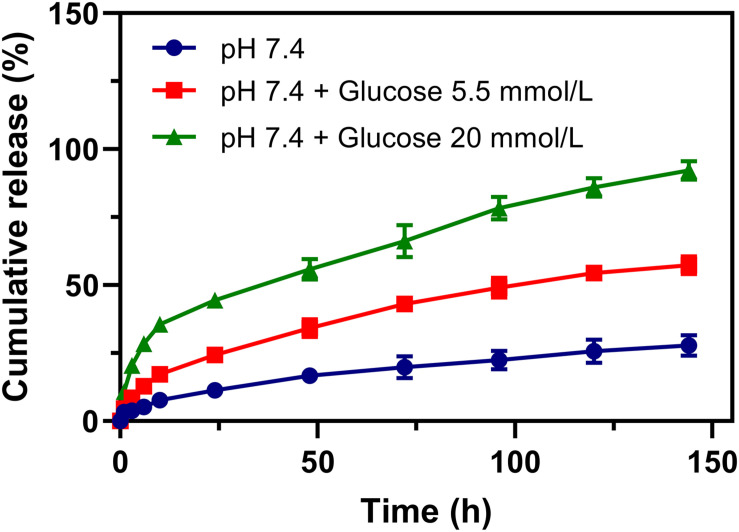
Rutin release profiles of Rutin@AgNPs in PBS (pH 7.4) excluded or included glucose (5.5 and 20 mmol/L).